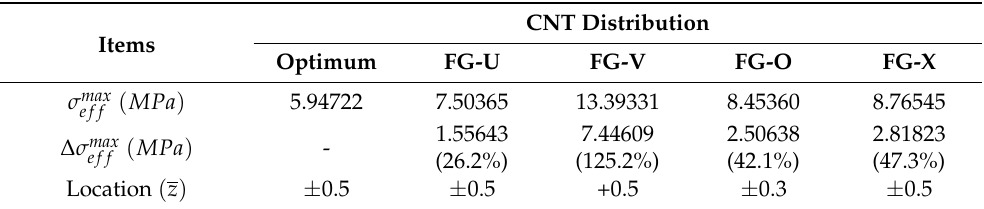
Table 5. Comparison of the maximum effective stresses between the optimum and conventional CNT distributions.